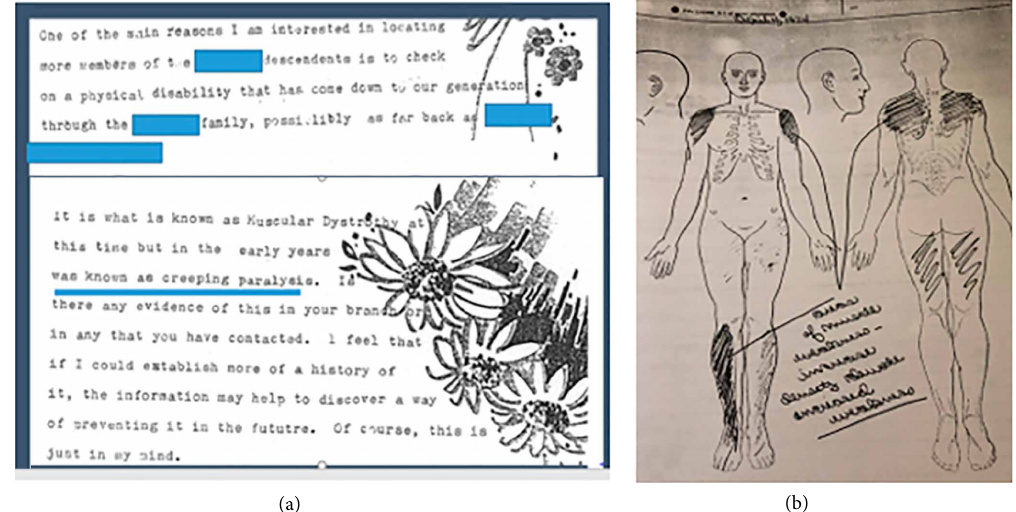
patient.Figure 3: 1978 letter from grandmother describing “creeping paralysis” (a) and grandmother’s exam shaded in at University of Iowa in 1974 depicting a “scapuloperoneal syndrome”